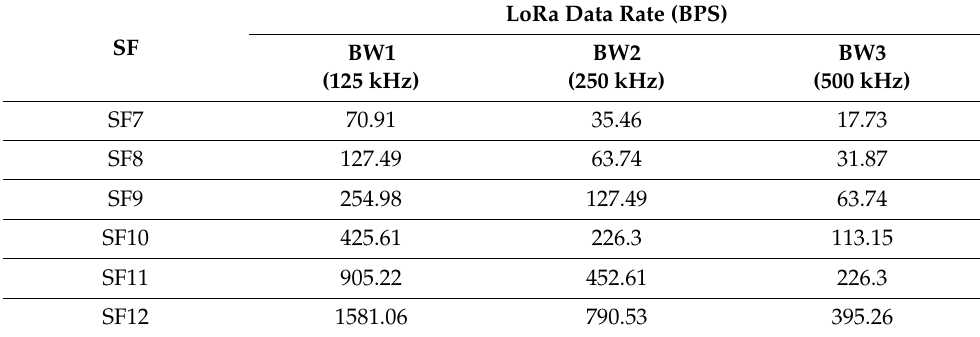
Table 12. Time on air (ToA) (ms) at